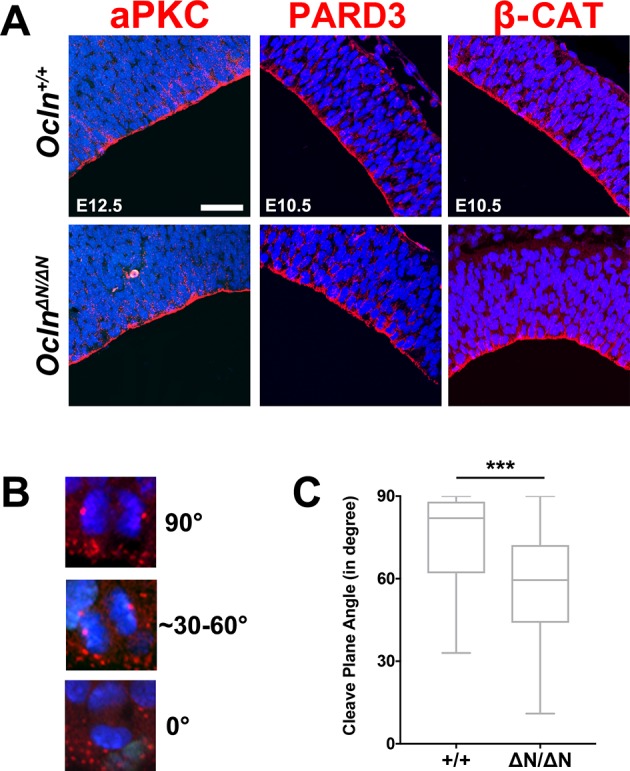
Intact organization of apical complex proteins and skewed cleavage plane orientation in Ocln-mutant mouse.(A) Confocal microscope images of coronal section from E12.5 control and mutant mouse cortices stained with apical complex markers atypical PKC (aPKC), Pard3, and B-catenin (all red) and counterstained with DAPI (blue). Scale bar, 50 μm. (B) Representative images for quantification of cleavage plane orientation angle. (C) Quantification of cleavage plane angle in control and mutant mice. All data points represent mean ± SEM, n = 52 Ocln+/+ cells and n = 70 OclnΔN/ΔN cells, from three independent experiments. Student’s t-test, ***p<0.001. Detailed tabulation of means, SEMs, sample sizes, and exact p-values can be found in Figure 3—figure supplement 1—source data 1.Figure 3—figure supplement 1—source data 1.Mean, SEM, sample size (n), and exact p-values for Figure 3—figure supplement 1 quantifications.